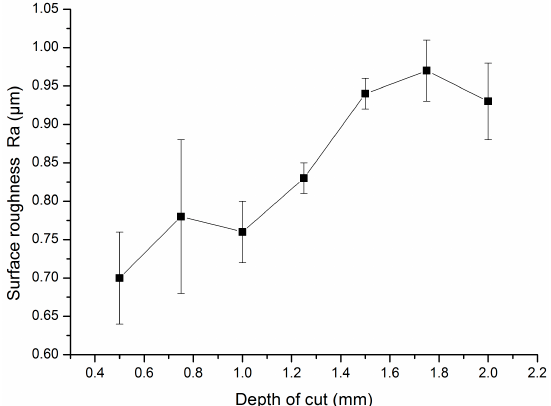
Figure 21. Evolution of the surface roughness against different depths of cut (cutting speed of 50 m/min, feed rate of 0.1 mm/r).